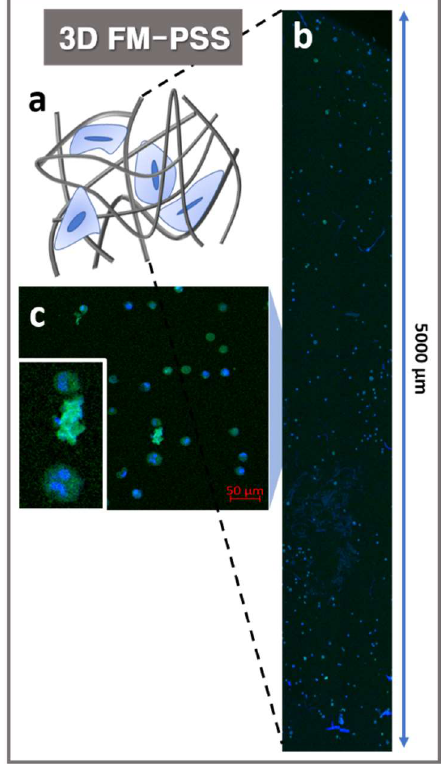
Figure 5. ( a ) Schematic illustration of the cells cultured in 3D FM-PSS. Z-stack image ( b ) and confocal microscopy image ( c ) of the cells on the 3D FM-PSS (inset: the enlarged image).